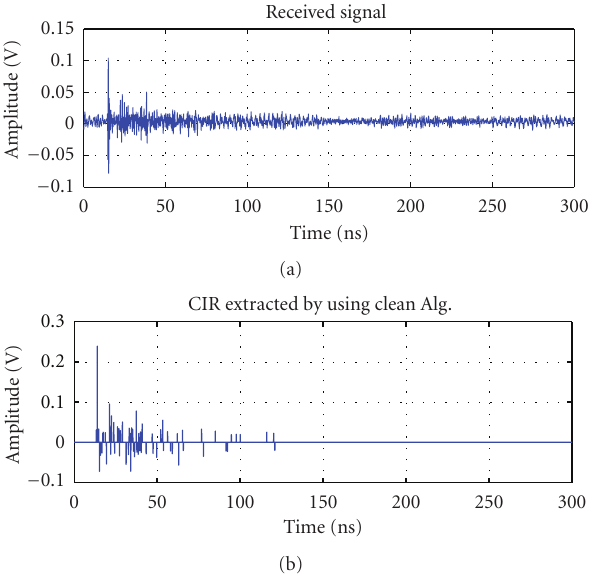
Figure 3: An example of the received signal and the extracted